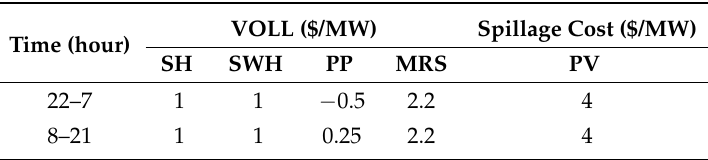
Table 3. Value of Loss Load (VOLL) and spillage costs. SH, Space Heater; SWH, Storage Water Heater; PP, Pool